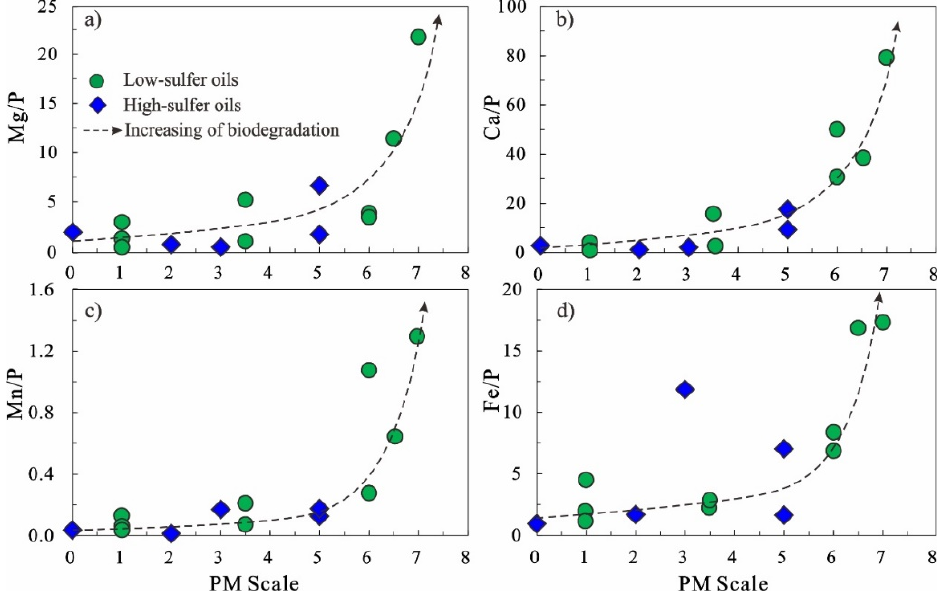
Figure 12. Cross plots of the degree of biodegradation (PM Scale) versus Mg/P ( a ), Ca/P ( b ), Mn/P ( c ) and Fe/P ( d ) ratios.